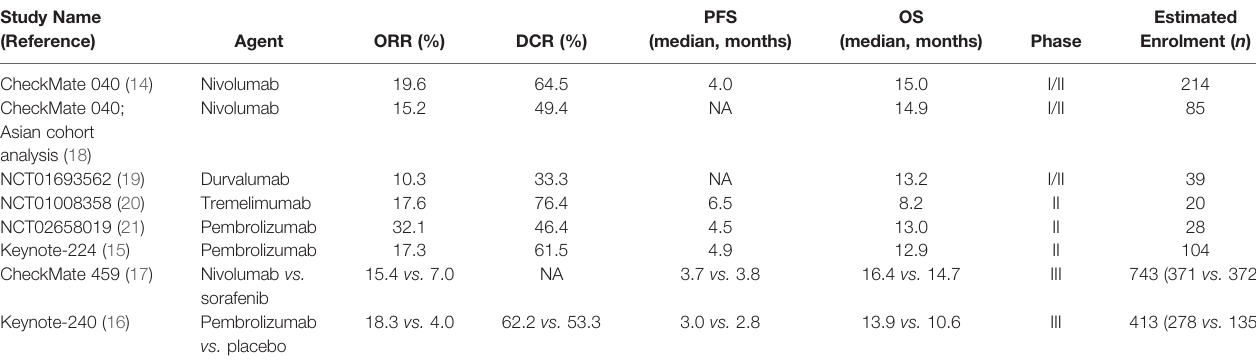
TABLE 1 | Clinical trials of immune-checkpoint inhibitors in hepatocellular